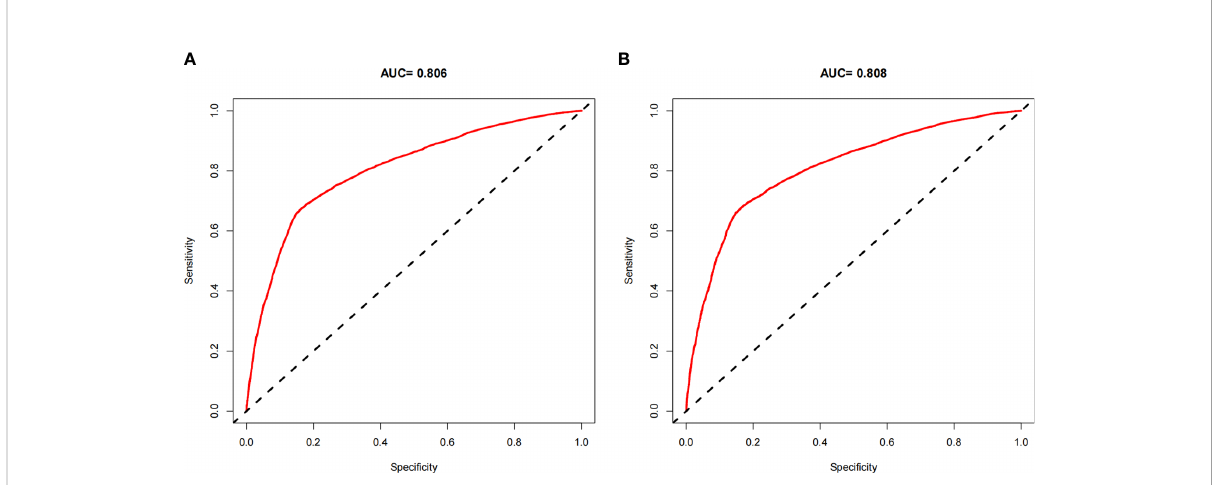
FIGURE 3 ROC curves for the nomogram. (A) The ROC curve for the all-cause early death nomogram in the SEER database; (B) The ROC curve for the cancer-speci fi c early death nomogram in the SEER database.